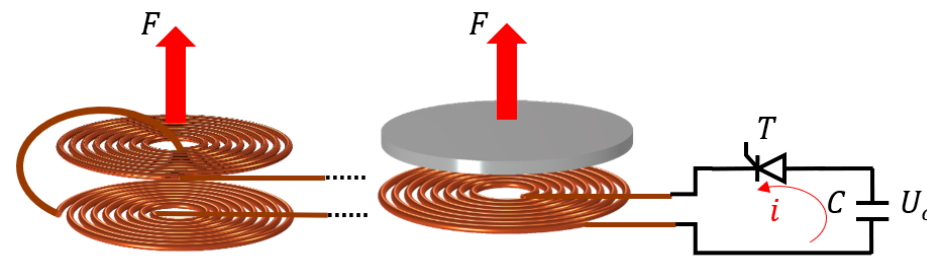
Figure 2. Principle of coil–coil and coil–disk repulsion mechanism.